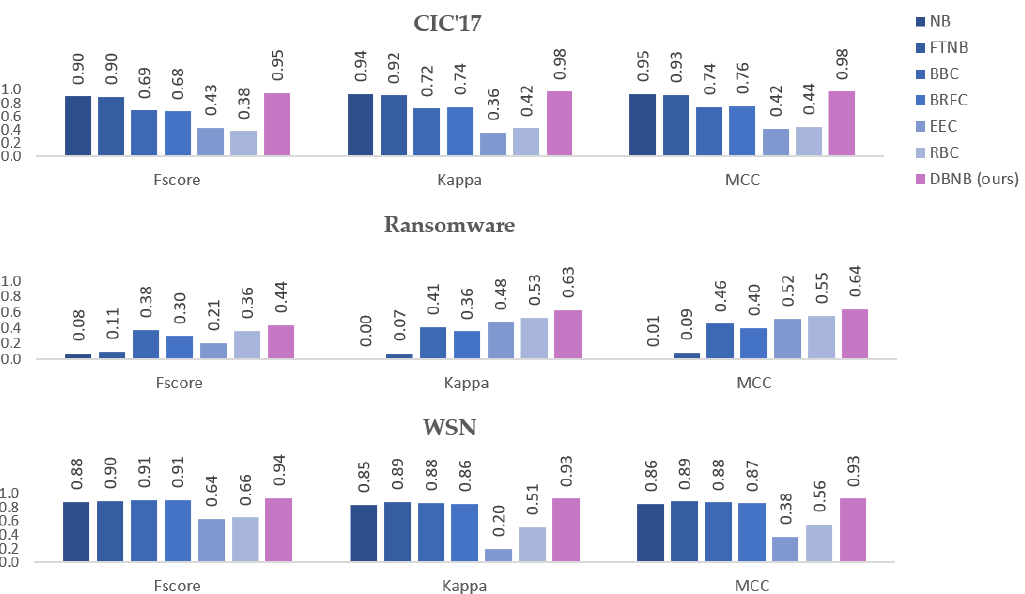
Figure 1. Macro F-score, Kappa, and MCC scores of CHNB compared with other classifiers on three imbalanced benchmark datasets.